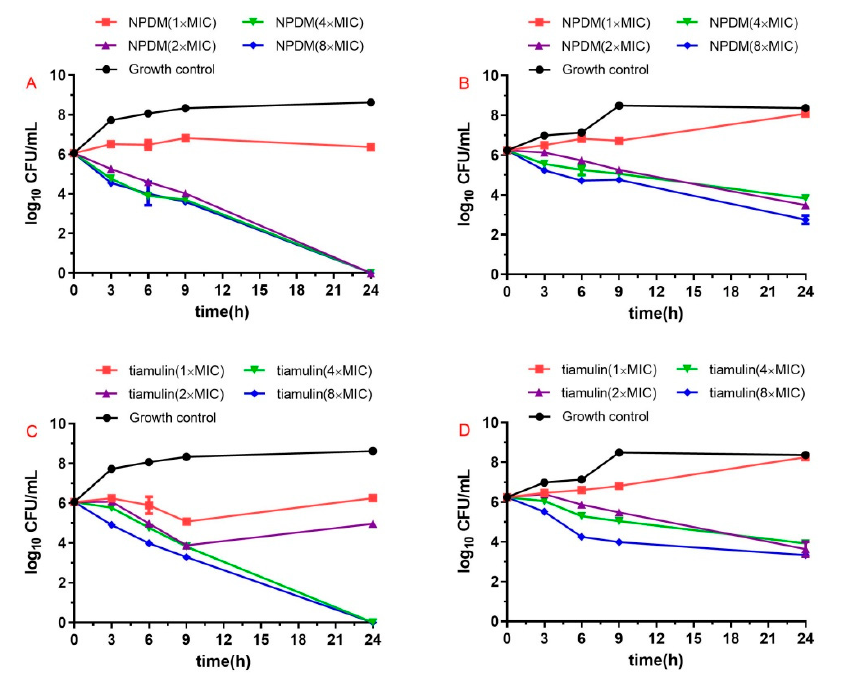
Figure 2. Time–kill curves for MRSA ATCC 43300 and S. aureus ATCC 29213 with different concen- trations of NPDM and tiamulin: ( A ) NPDM against MRSA; ( B ) NPDM against S. aureus ; ( C ) tiamulin against MRSA; ( D ) tiamulin against S. aureus .